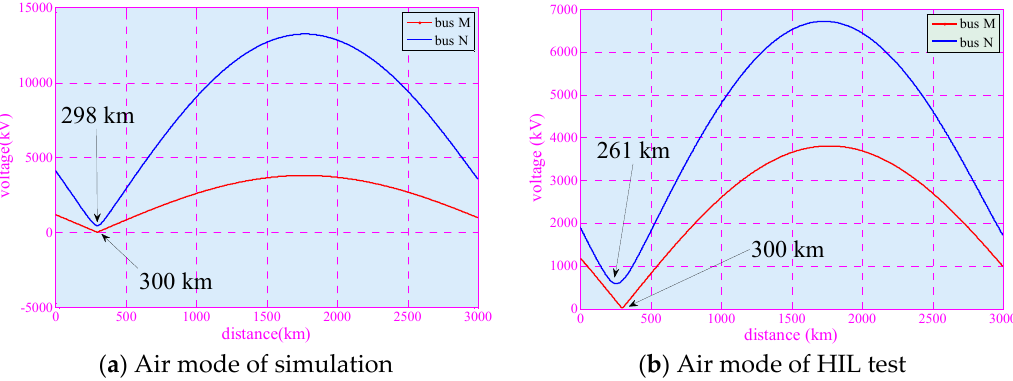
Figure 11. A phase-A-to-phase-B (AB) fault with 10 Ω fault resistance, 300 km away from bus M, with 210 MW wind power.